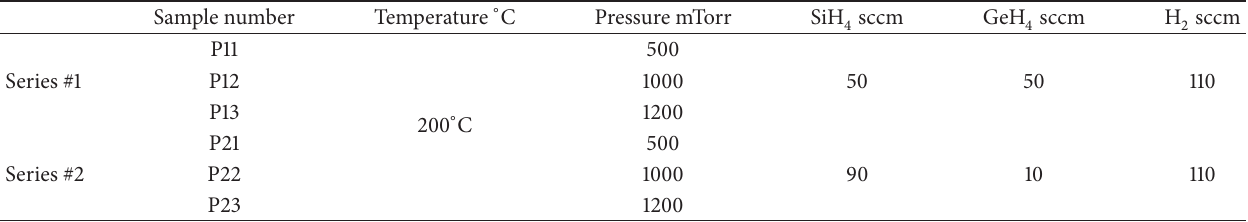
Table 1: Deposition conditions of two series of pm-Si 𝑥 Ge 𝑦 :H thin films prepared by